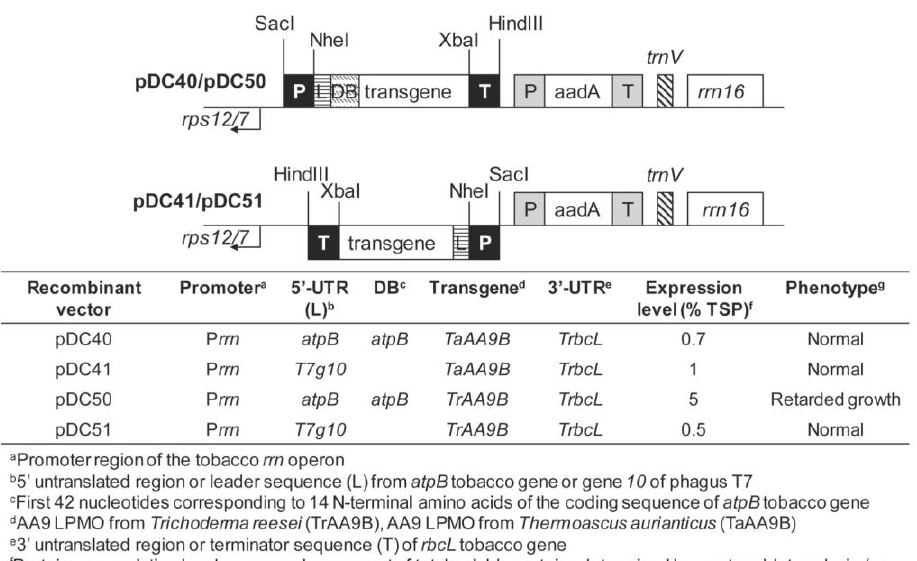
Figure 1. Schematic representation of plastid transformation vectors containing transgenes encoding the family AA9 of LPMOs from Thermoascus aurantiacus (TaAA9B) and Trichoderma reesei (TrAA9B). For each vector, regulatory sequences, protein accumulation level and phenotype in corresponding transplastomic plants are indicated.